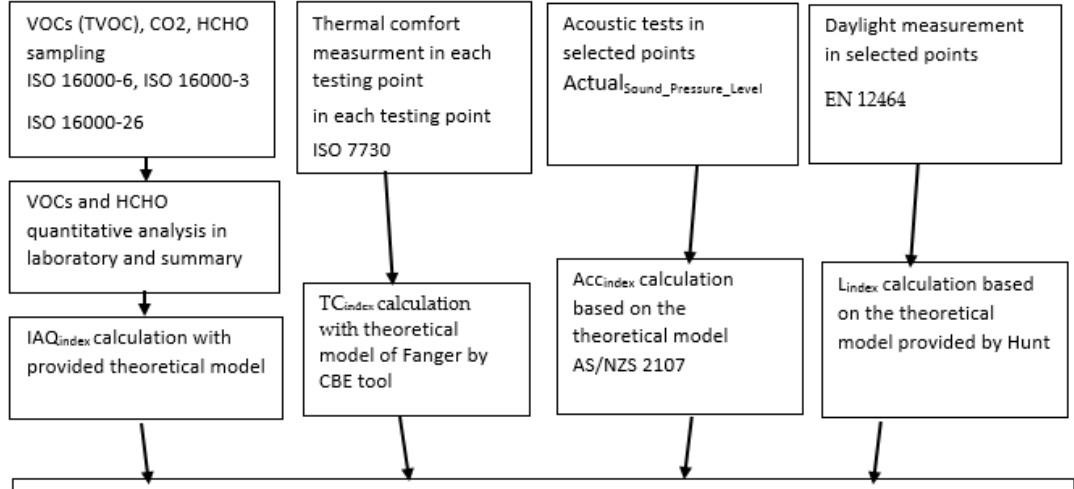
Figure 1. The experimental strategy to assess each comfort element of indoor environmental quality (IEQ) model.